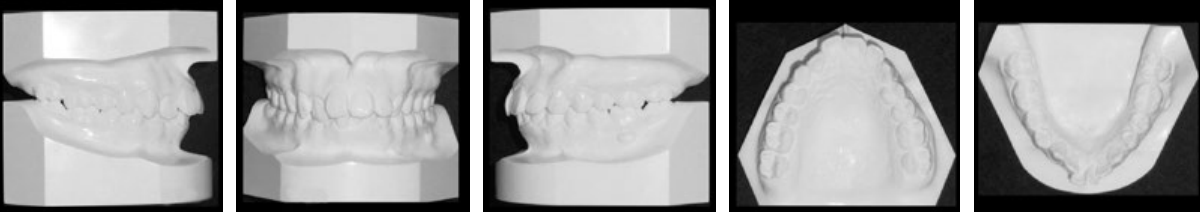
Figure 2. Pretreatment dental